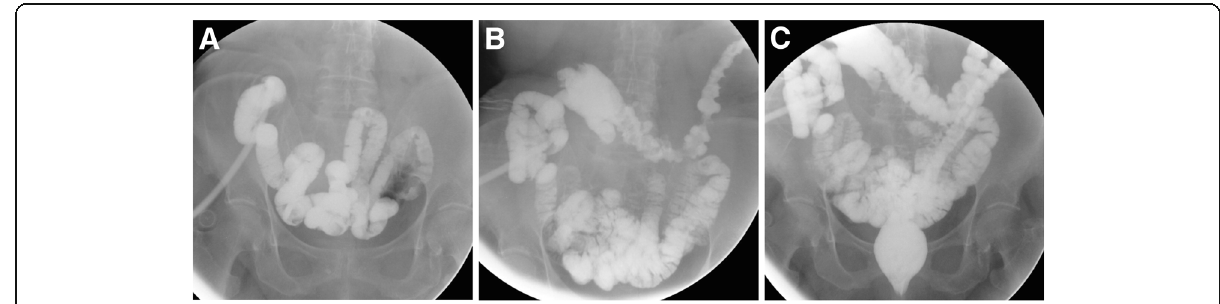
Fig. 4 Double WSC-SE at a loop ileostomy following recent ileocecal resection for Crohn ’ s disease, performed via the afferent ( a ) and efferent ( b , c ) limbs, obtaining opacification of the residual large bowel up to the rectum